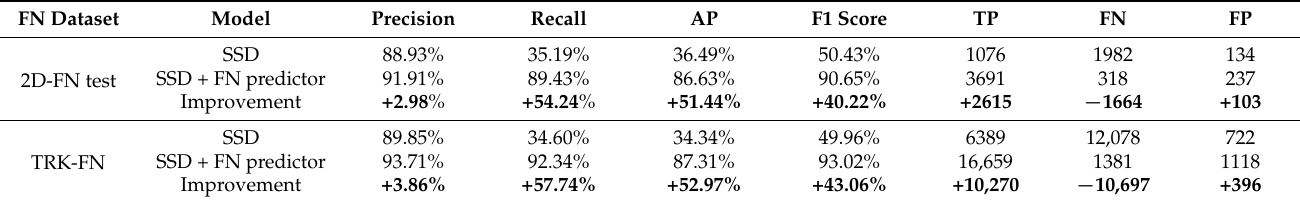
Figure 8. PR Curves on different datasets. ( a ) PR Curves on the 2D-FN test dataset. ( b ) PR Curves on the TRK-FN dataset. PR Curves of the FN prediction performance are labeled as FN, the object detection performance of the given object detector are labeled as SSD, and the object detection performance when taking FN predictions into consideration are labeled as SSD+FN. Therefore, the quantitative improvements to the object detection performance can be visualized by comparing the SSD+FN PR Curve with the SSD curve. Table 2. Quantitative improvements to object detection.